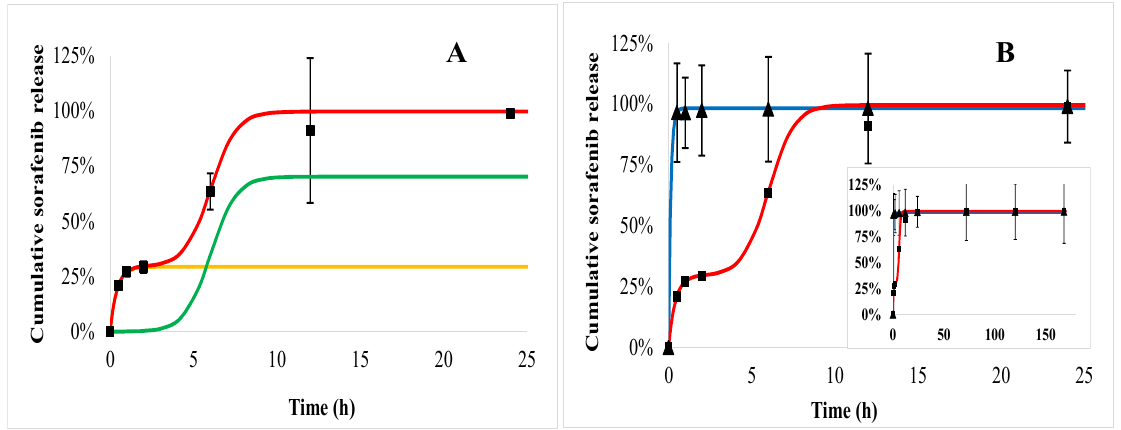
Figure 8. Sorafenib cumulative release from PHB nanoparticles measured in blood plasma (trigons) and acid (squares). The fitted release profiles in plasma (blue) and in acid (red) are also drawn. The modeled release profiles are shown as follows: the release kinetics in acid ( A ) was constructed from an initial burst (yellow line) and polymer degradation (green line). In the insert ( B ), the measured data and the fitted release profiles can be seen on the whole time scale.